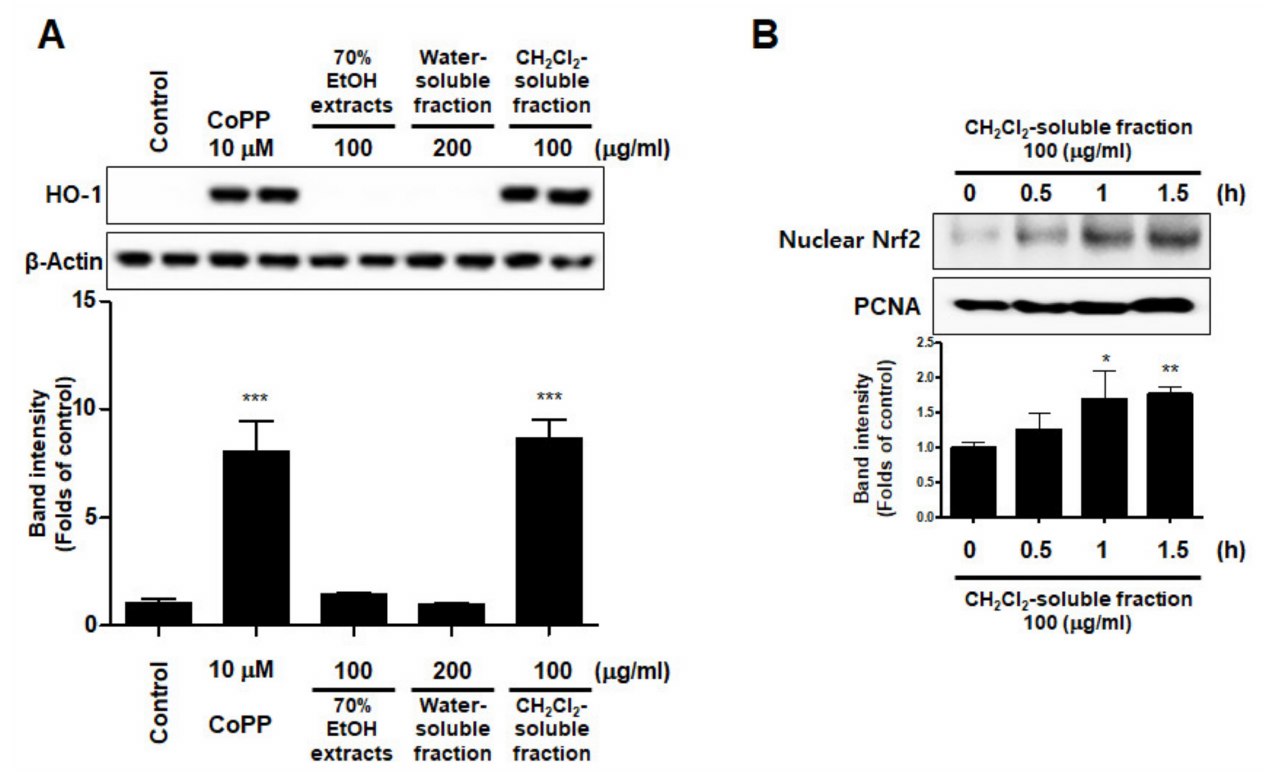
Figure 11. Effects of 70% EtOH extract and its water- and CH 2 Cl 2 -soluble fractions on the protein expression levels of HO-1 ( A ) and the nuclear translocation of nuclear factor erythroid-derived 2-related factor-2 (Nrf2) by the CH 2 Cl 2 -soluble fraction ( B ) in BV2 cells. ( A ) Cells were incubated for 12 h with the indicated concentration of each sample. ( B ) These cells were treated with CH 2 Cl 2 -soluble fraction for 0.5, 1, or 1.5 h, and then the nuclei were fractionated from the cytosol using a Cayman Nuclear Extraction Kit. HO-1 and nuclear Nrf2 expression were then determined by Western blotting. Band intensities were normalized to β -actin or PCNA. Cobalt protoporphyrin (CoPP, 10 µ M) was used as a positive control. Data are presented as the mean ± standard deviation of 4 ( A ) or 3 ( B ) independent experiments. * p < 0.05, ** p < 0.01, *** p < 0.001 compared to the control group. Control means an untreated control